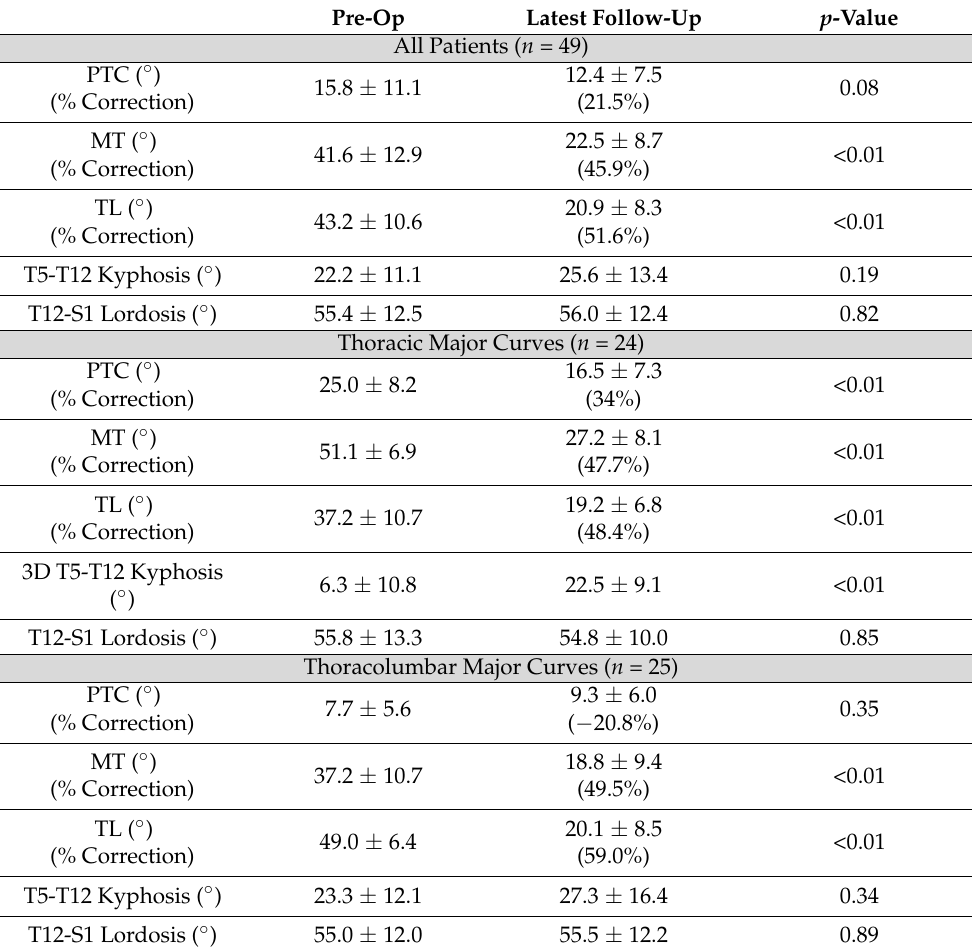
Table 2. Radiographic